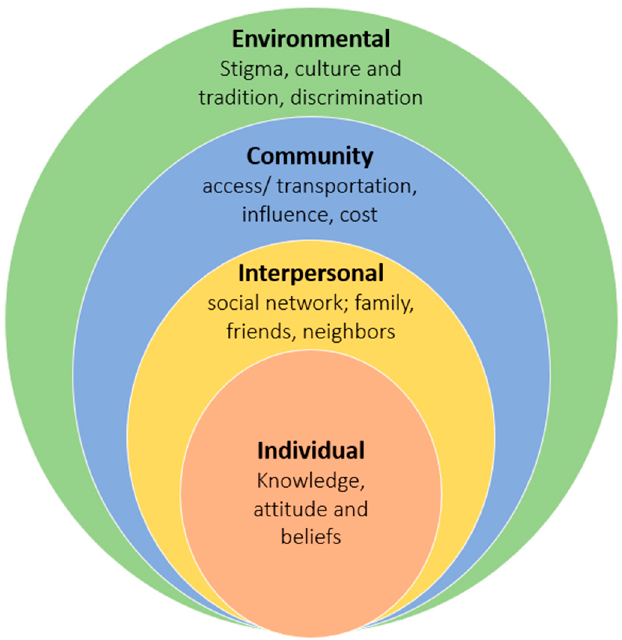
Figure 1. An adaptation of the socioecological model by McLeroy et al.